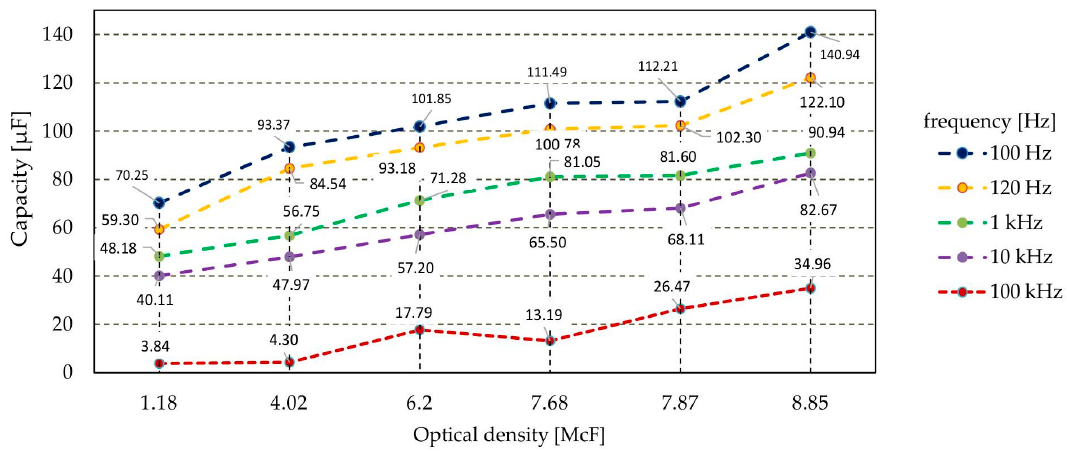
Figure 12. The dependence of the sensor capacity with regard to the number of bacteria in the suspension.